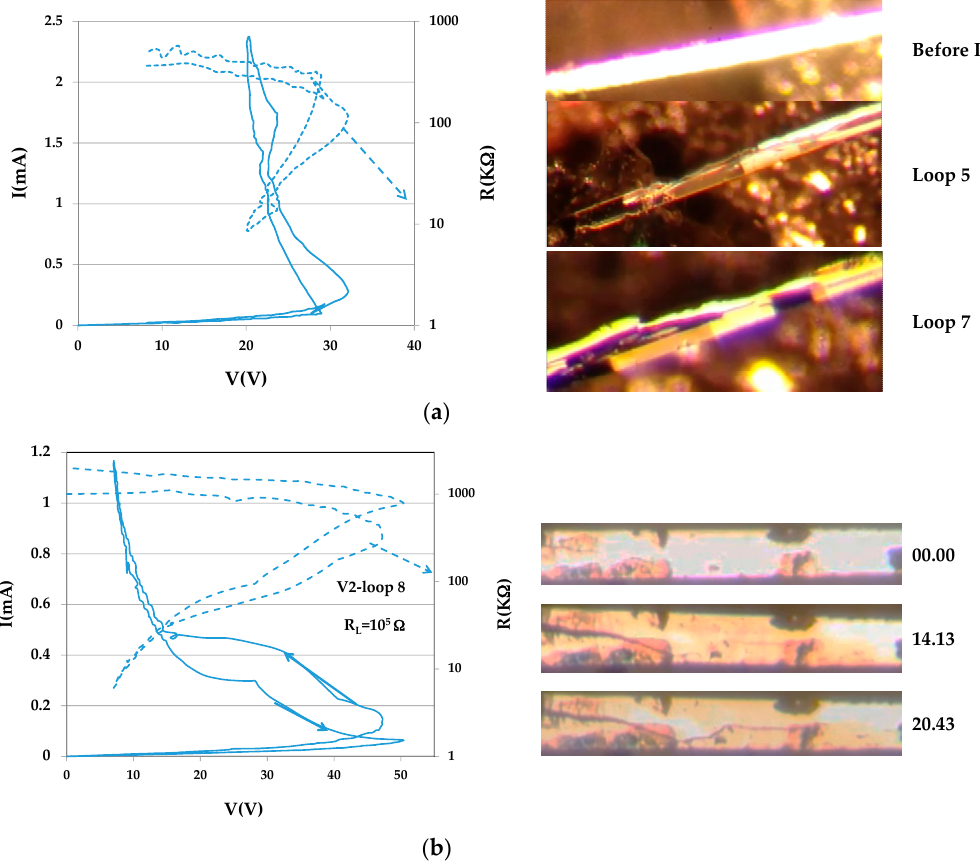
Figure 8. ( a ) The image of a portion of sample V1 before I–V cycling, an instant during the fifth loop when the cracks became visible (I–V at left) and during Loop 7; ( b ) A portion of sample V2 at three instances during switching in its eighth I–V loop (left).